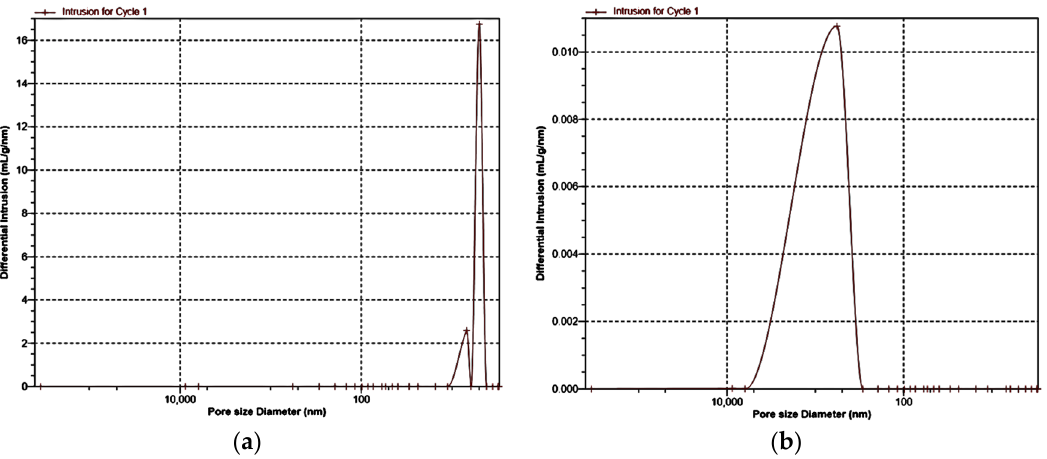
Figure 4. Differential intrusion (pore volume) versus pore size diameter in ( a )—nonwoven fabric; ( b )—nonwoven fabric after thermal stabilization.